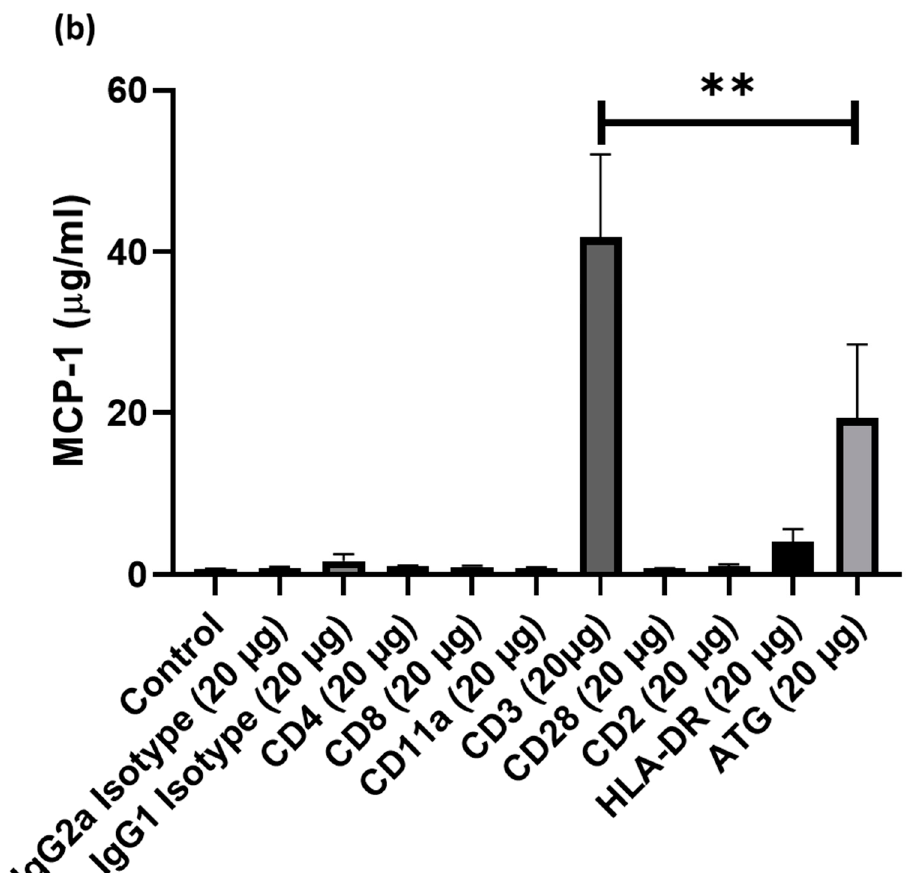
Figure 1. Cell cultures of human peripheral blood mononuclear cell (PBMC)were supplemented with different doses of Anti-thymocyte globulin (ATG) or various anti-T-cell antibodies, such as treatment with anti- (1) IgG2a, (2) IgG1, (3) CD4, (4) CD8, (5) CD11a, (6) CD3, (7) CD28, (8) CD2, (9) HLA-DR. After 24 h incubation, supernatants were collected and the concentration of IL-8 and MCP-1 was assessed by enzyme-linked immunosorbent assays (ELISA). Only the addition of anti-CD3 antibodies led to a pronounced ( a ) IL-8 and ( b ) MCP-1 expression compared with other epitopes in PBMCs. ( p -values were expressed as follows: ** p < 0.01, *** p < 0.001).